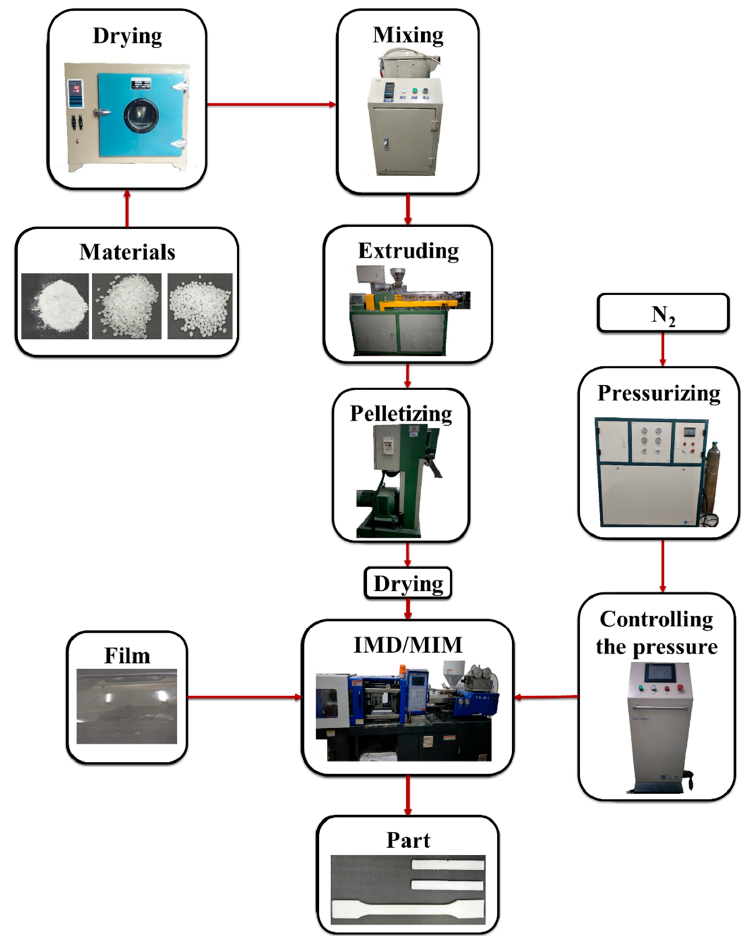
Figure 3. Process flow chart.